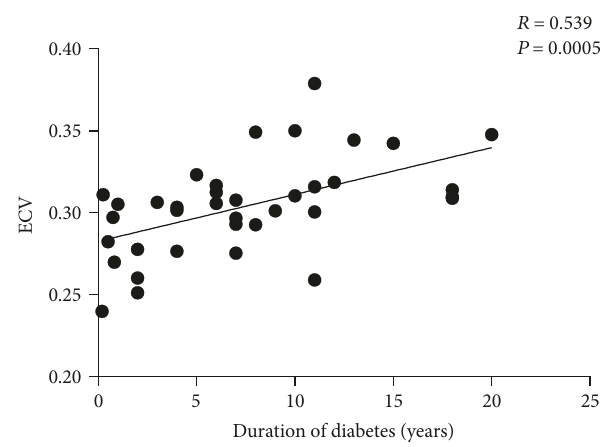
Figure 3: Relationship between ECV and the duration of diabetes.